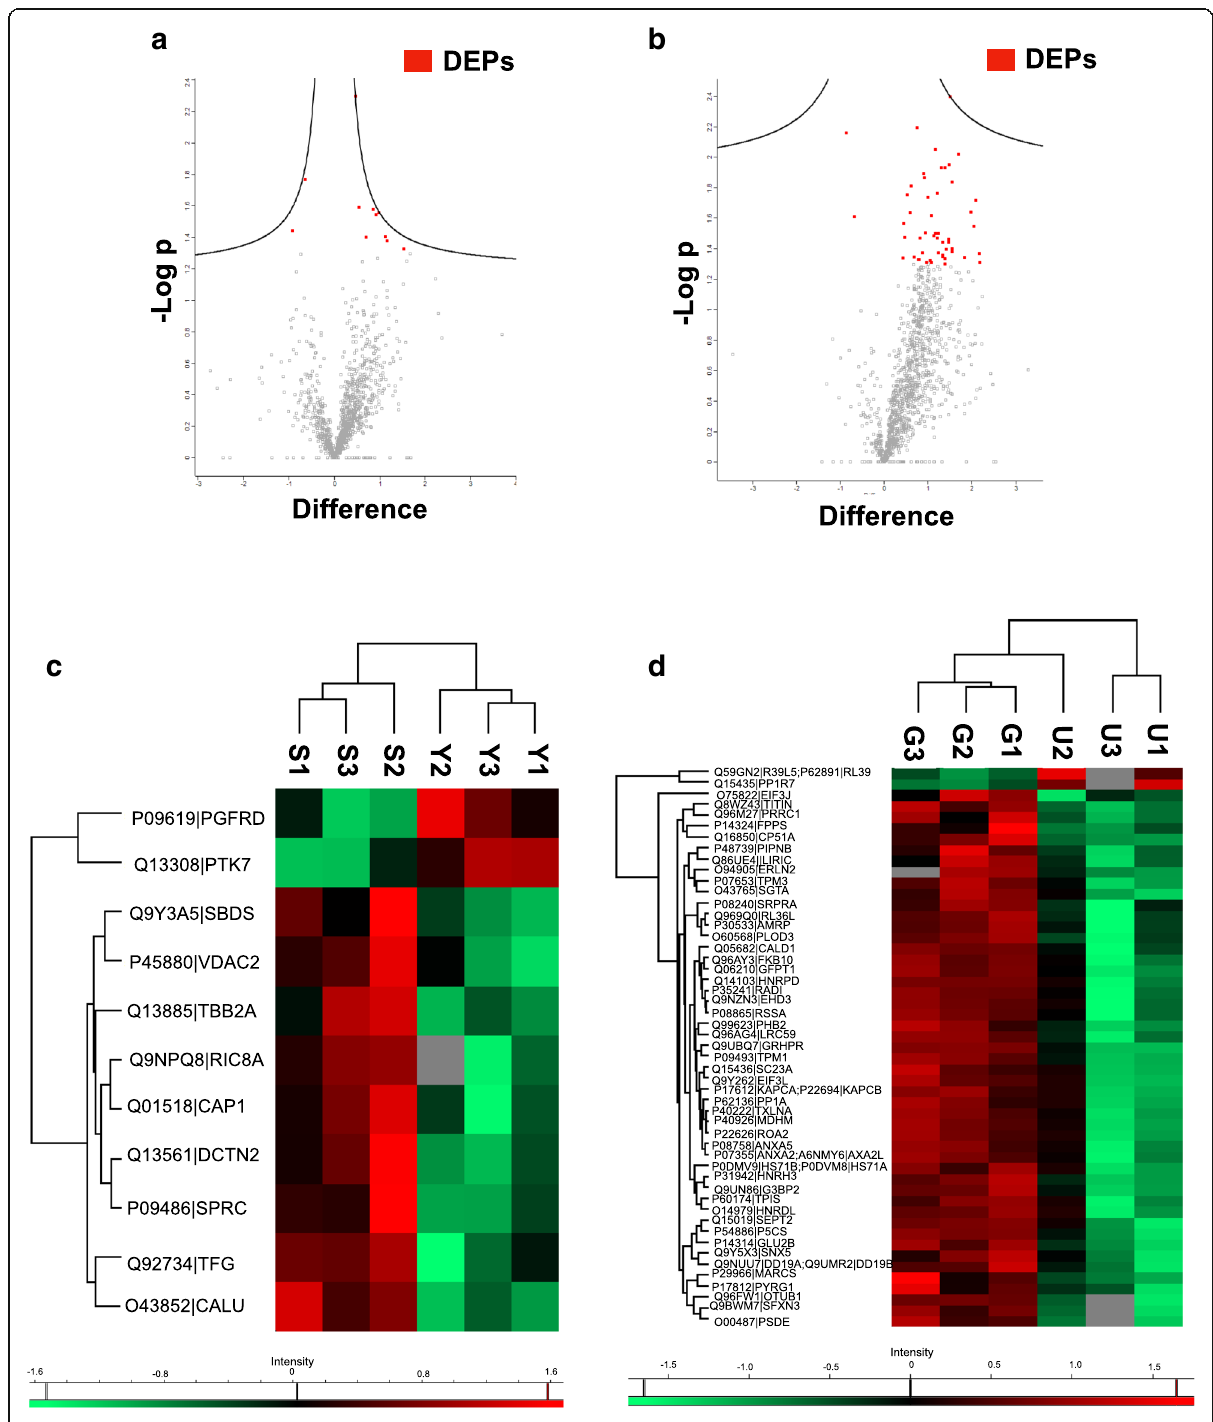
Fig. 1 Graphical representations of differentially expressed proteins (DEPs). Volcano plot of total proteins for ( a ) young versus senescent cells and ( b ) vehicle- versus γ T3-treated senescent cells. DEPs were highlighted in red. Heat map of DEPs for ( c ) young versus senescent cells and ( d ) vehicle- versus γ T3-treated senescent cells. Y1 – 3: young cells; S1 – 3: senescent cells U1 – 3: vehicle-treated senescent cells; G1 – 3: γ T3-treated senescent cells; N = 3 biological replicates for each group. Scale bar: young cells were set as control group for senescent cells; vehicle-treated senescent cells were set as control group for γ T3-treated senescent